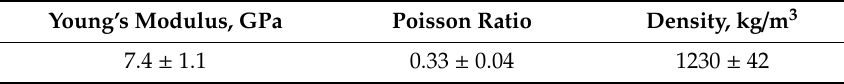
Table 1. Mechanical properties of the studied plate’s